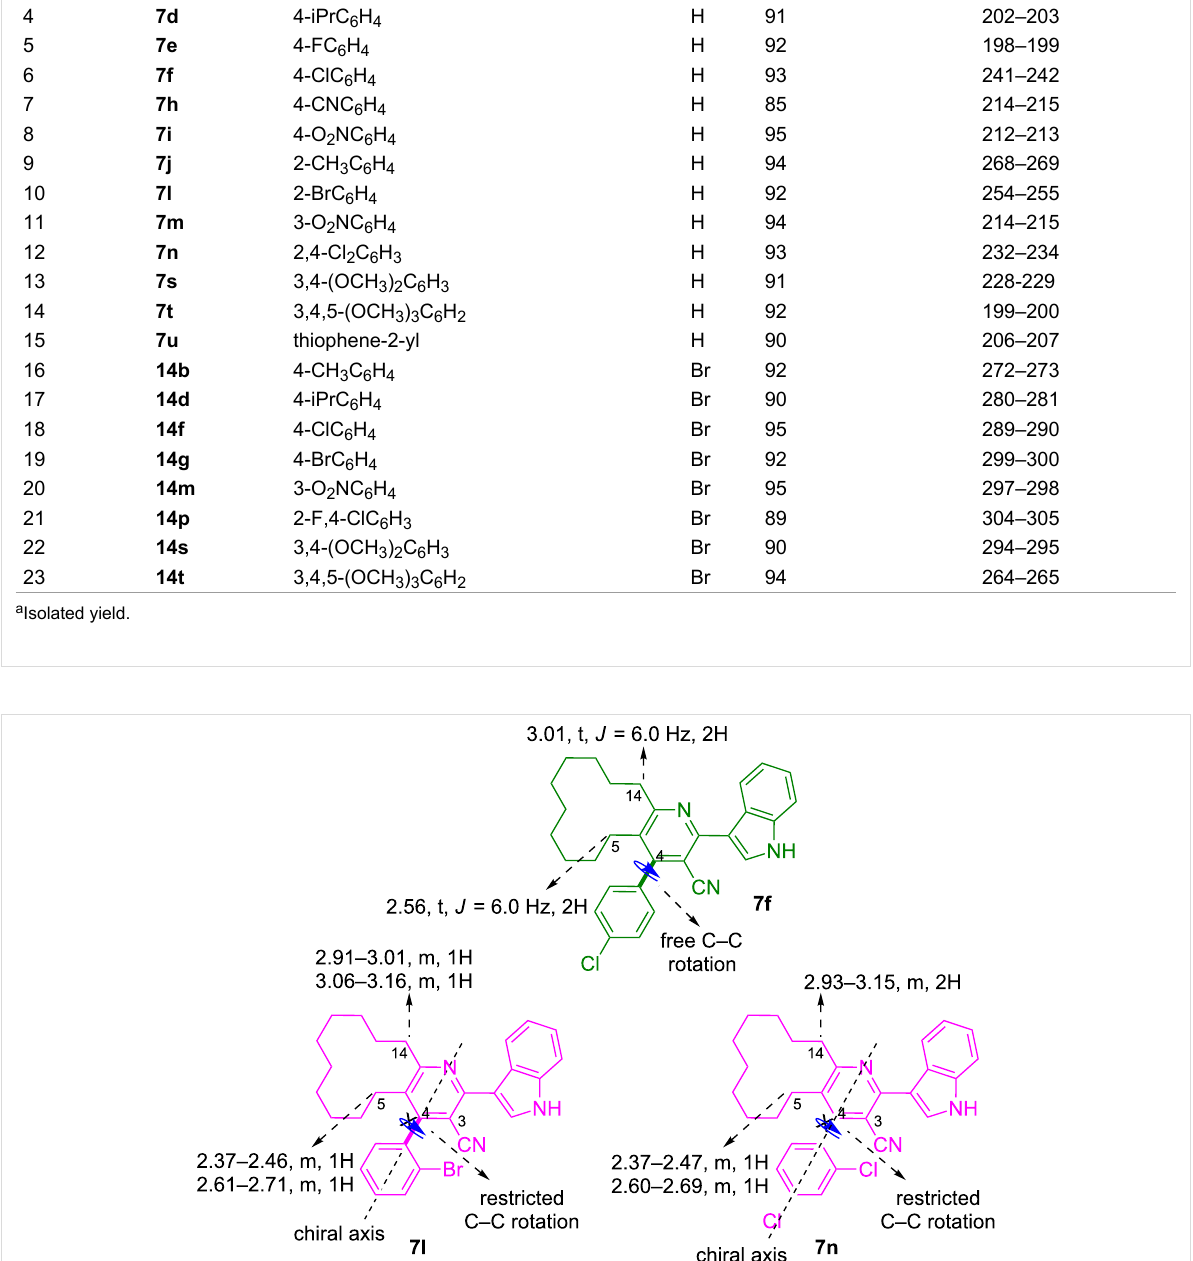
afford the aromatized product 7 . However, in other cases (Table 2) the reaction was complete within 2 h (TLC analysis) but the product 7 precipitated after 6–8